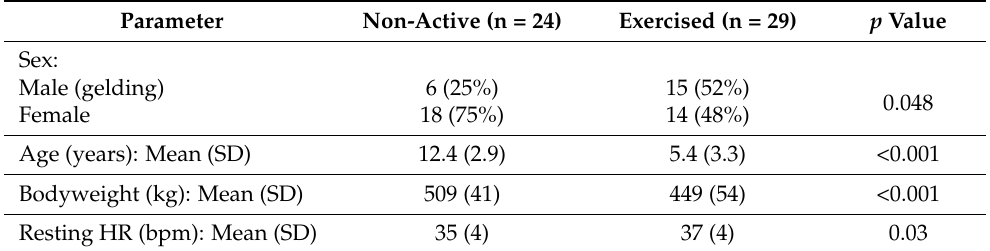
Table 1. Baseline details for non-active horses compared with those in race training.